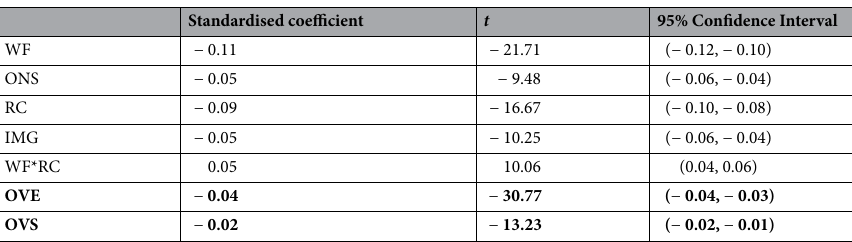
Table 1. Linear mixed-effect model fitted to phonological SSE produced by the model. All predictors were scaled. An effect was considered significant at the p < 0.05 level if its t-value was greater than 1.96 46 . WF word frequency, ONS orthographic neighbourhood size, RC rime consistency, IMG imageability, OVE oral vocabulary exposure, OVS oral vocabulary